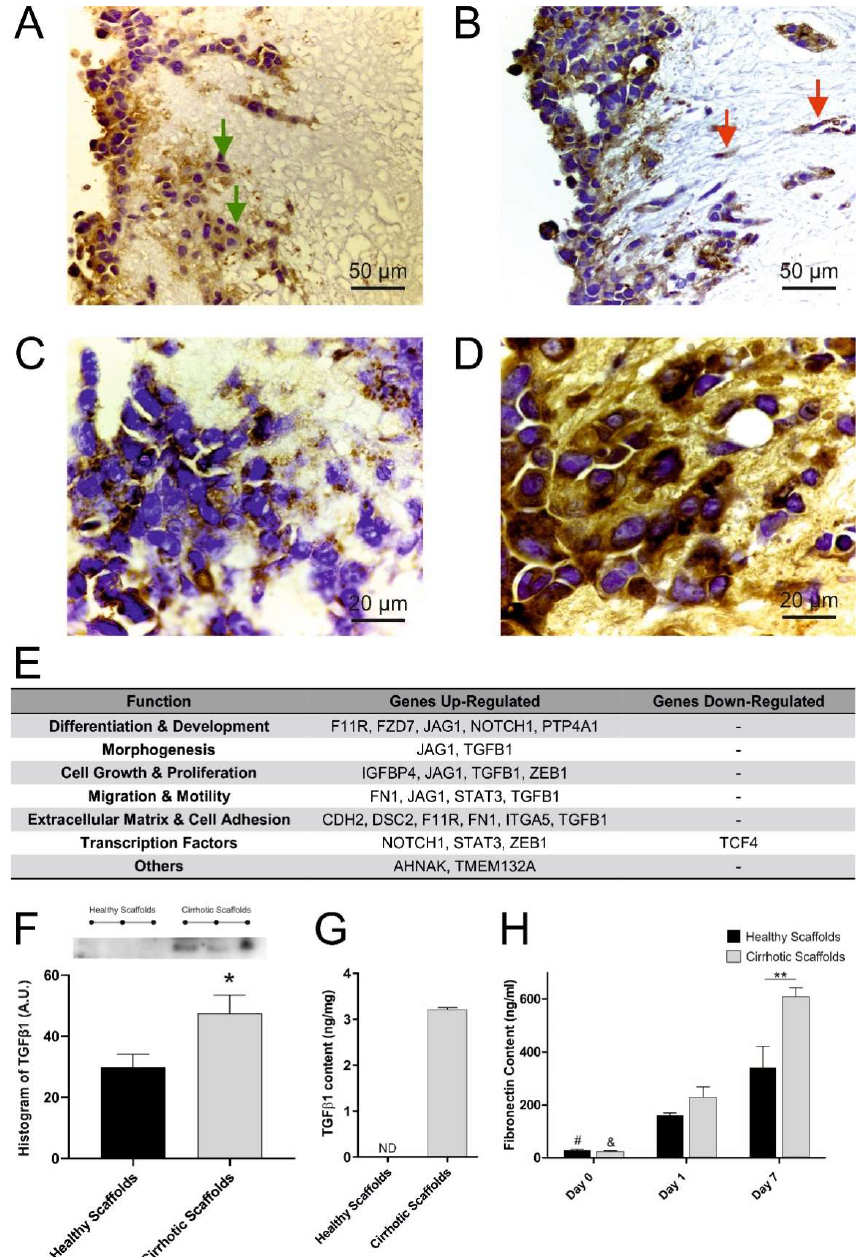
Figure 4. Cirrhotic 3D ECM scaffolds drive EMT in HepG2 cells. Epithelial cell adhesion molecule (EPCAM) immunohistochemistry of HepG2 cells engrafted in ( A ) healthy 3D scaffolds (green arrows) and ( B ) cirrhotic 3D scaffolds (scale bar 50 µm) (red arrows showing more mesenchymal phenotype), and alpha fetoprotein (AFP) immunohistochemistry of HepG2 cells engrafted in ( C ) healthy 3D scaffolds and ( D ) cirrhotic 3D scaffolds (scale bar 20 µm). ( E ) Overview of RT2 Profiler PCR Array for EMT performed in HepG2 cells grown on healthy and cirrhotic 3D scaffolds, which showed significant upregulation of EMT-related genes in HepG2 cells engrafted in 3D cirrhotic scaffolds (fold change of 2 and p ≤ 0.05). ( F ) Western blot analysis demonstrating significant increase in TGFβ1 protein expression in acellular cirrhotic 3D scaffolds in comparison to